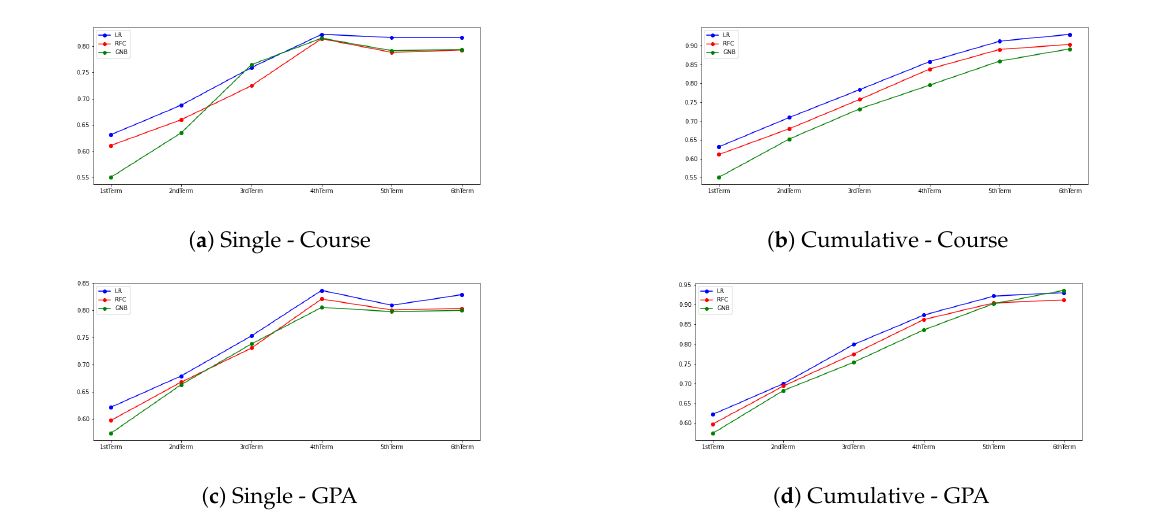
Figure 7. Accuracy plots along the terms of the ML Models with the academic and pre-college features.